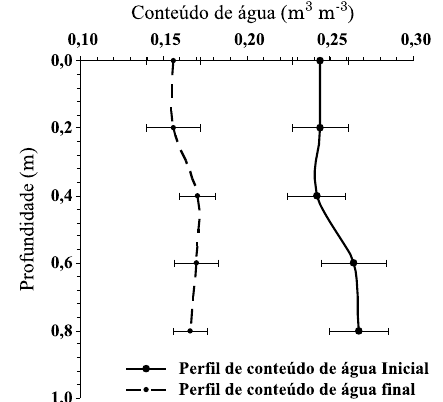
Figura 4. Perfis de conteúdo de água inicial e final dos processos de redistribuição da água no solo para os 60 locais amostrais e os respectivos desvios-padrão. O conteúdo de água na superfície do solo foi considerado igual ao da profundidade de 0,2 m.